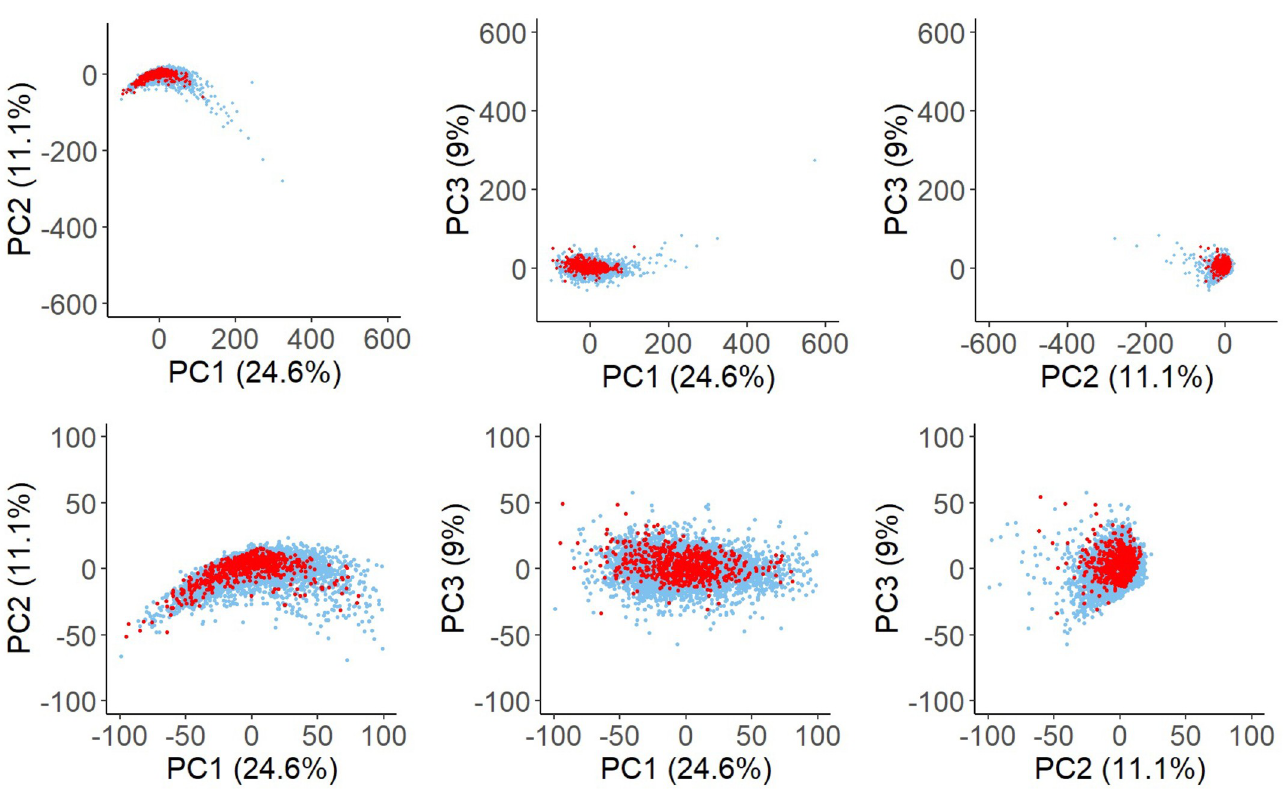
Fig 1. The PCA plots of the 652 target drugs and the 12,262 PubChem reference compounds. The PCA was performed using the 1,539 Dragon 7 descriptors. The plots of PC1 vs. PC2 (left), PC1 vs. PC3 (center) and PC2 vs. PC3 (right) are shown. The upper panels are the original views of all the compounds and the lower panels are the expanded views around the target drugs. Each dot represents a compound (red, target drugs; blue, PubChem compounds).